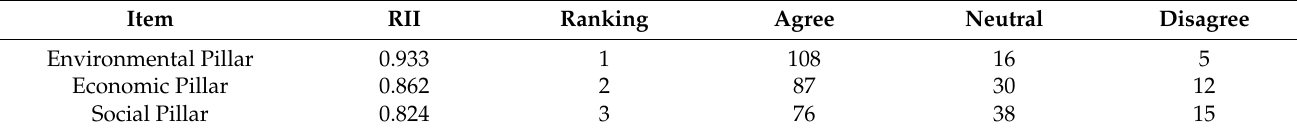
Table 10. RII ranking of the three pillars of sustainability in terms of their relevance to SC.